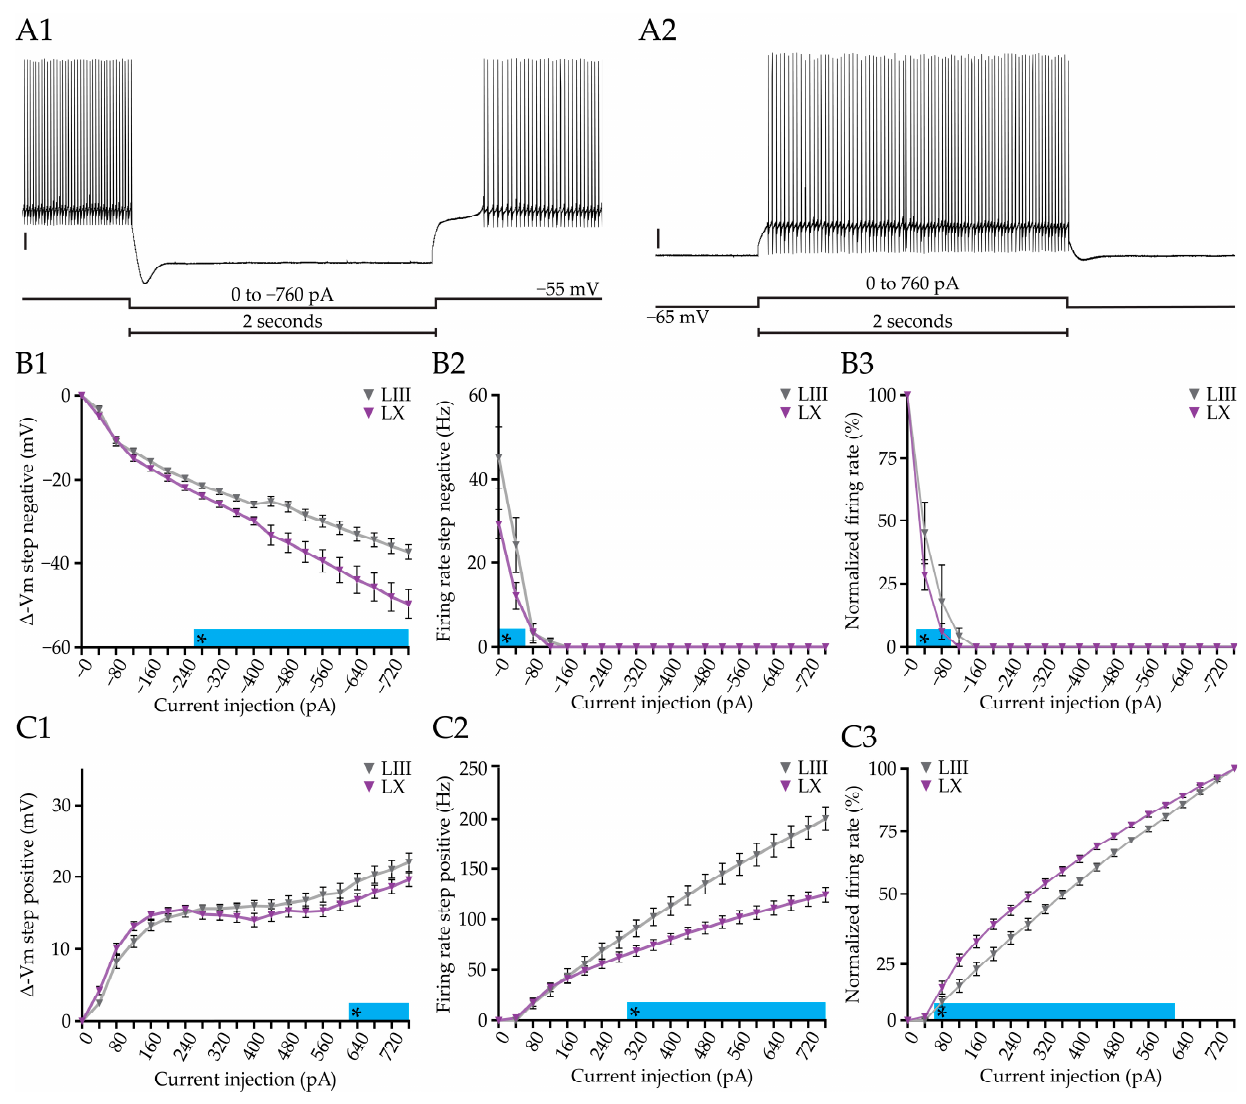
Figure 2. Positive and negative current injections in Purkinje cell from lobules III and X. ( A ), example traces of negative ( A1 ) and positive ( A2 ) current steps, initiated from a resting membrane potential of –65 mV and –55 mV, respectively. ( B ), Plots of the voltage change ( B1 ) absolute firing rate ( B2 ), and normalized firing rate (( B3 ), to the rate at 0 pA), induced by a range of negative current injections (0 to –760 pA). ( C ), Similar analysis of the effect of different positive current injections, starting from − 65 mV, on membrane potential (( C1 ), plotted as voltage change), absolute firing rate ( C2 ), and normalized firing rate (( C3 ), normalized to the value of +760 pA). Vertical scale bar in ( A1 ) 10 mV; ( A2 ) 10 mV. Asterisk denotes p < 0.05. See Table S2 for all statistical data.